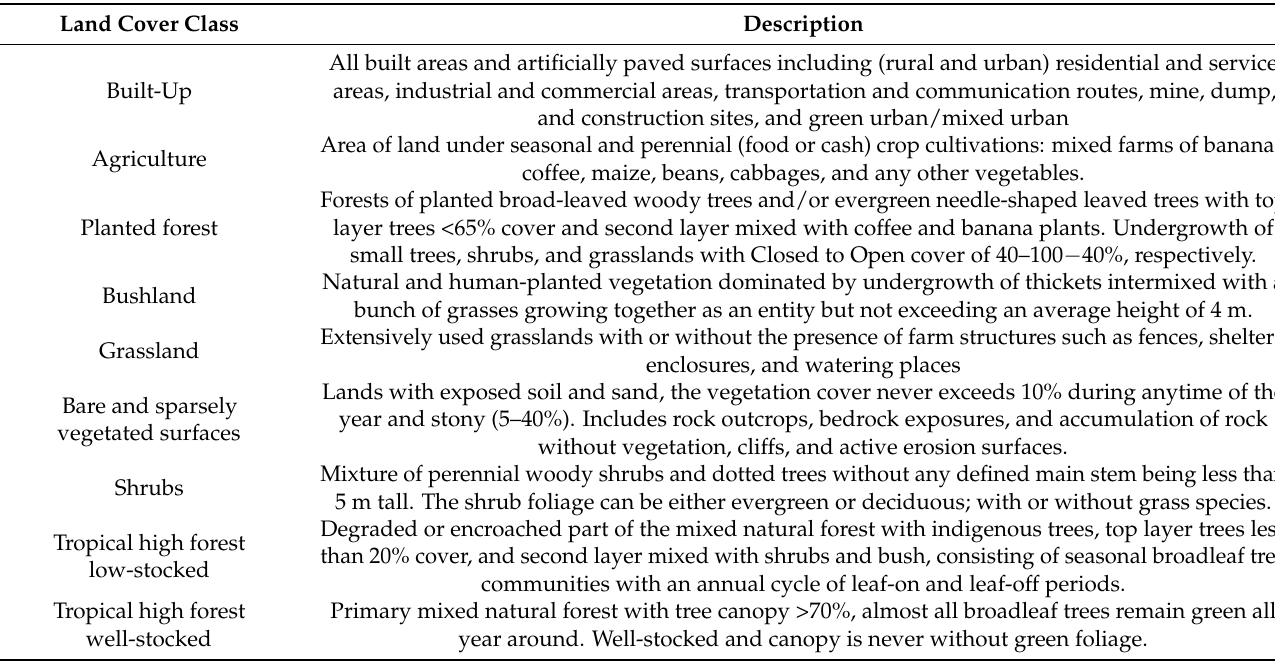
Table 1. Land Cover Classification scheme used in this